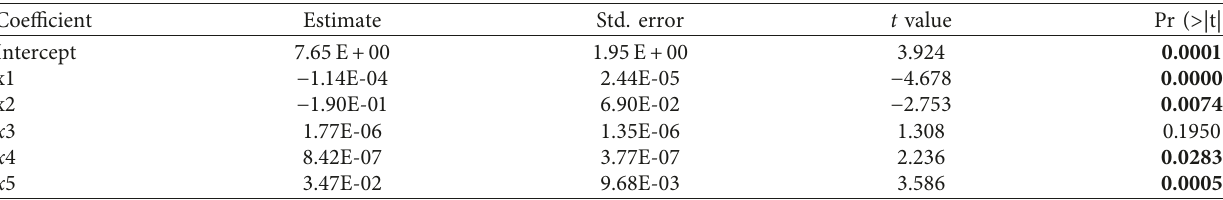
Figure 1: Spatial distribution of total fertility rate in Turkey for 2020. Table 3: Coefficients for the multiple regression models.